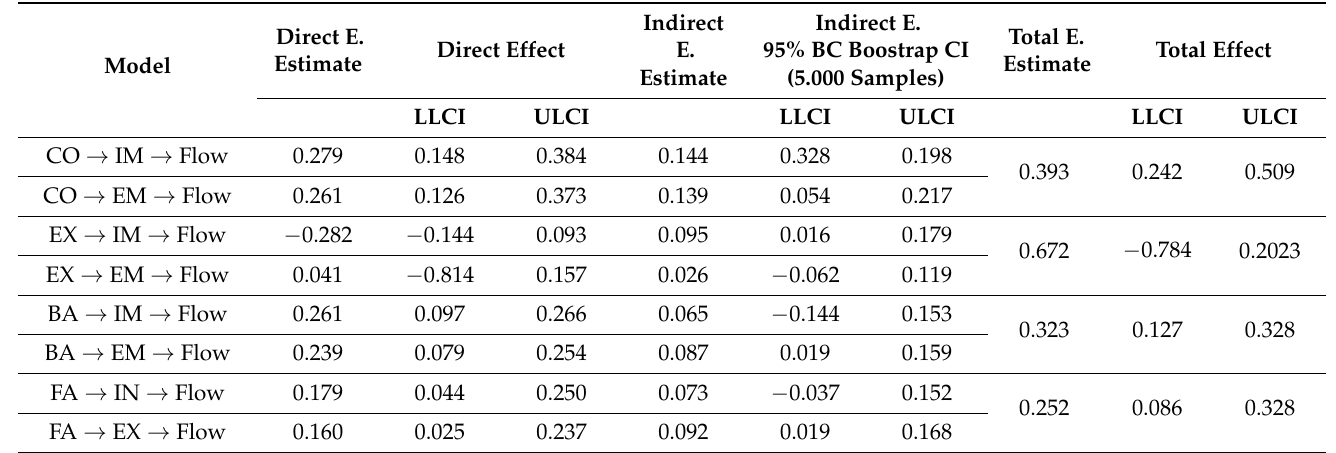
Table 3. Direct and Indirect effects of fascination (FA), extent (EX), being away (BE), and compatibility (CO) on flow through intrinsic (IM) and extrinsic motivation (EM), and total effects. Direct Model